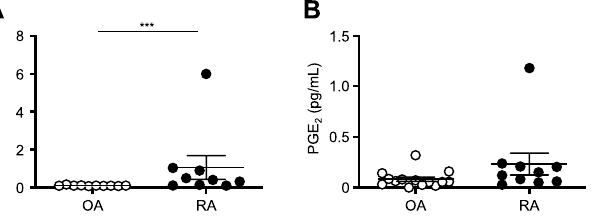
Figure 6. Comparison of PGD 2 and PGE 2 concentrations in SF obtained from OA and RA patients. SF was obtained from OA (n = 14) and RA (n = 10) patients. Each point represents one donor. Significance was determined using the Mann–Whitney U test (*** P <